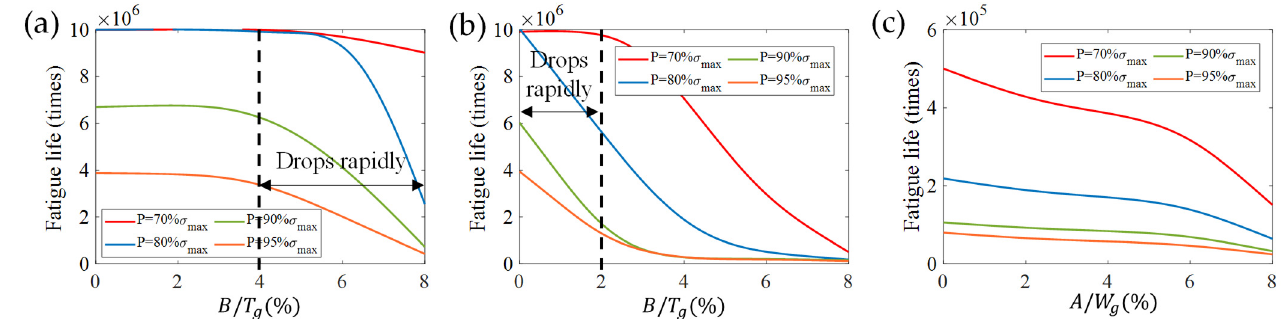
Figure 12. Fatigue life of sensitive grids for different surface roughness ( a,b ) and side-wall profile ( c ) under varying stress loading. ( a ) longitudinal, ( b ) transverse surface texture mode, and ( c ) side-wall profile of sensitive grids.